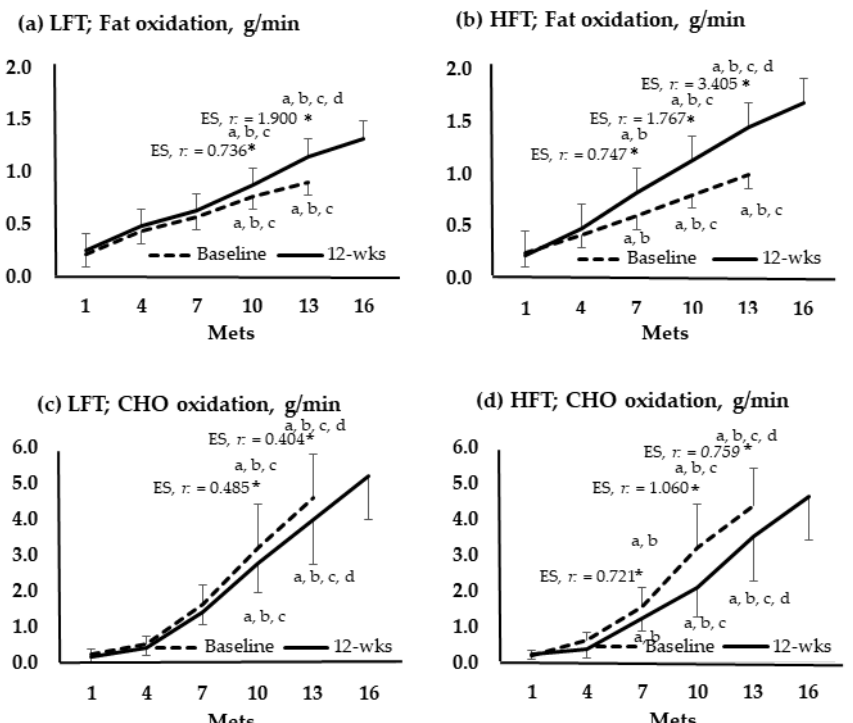
Figure 4. Oxidation of fats and carbohydrates according to the graded exercise test stage. *, p < 0.05;